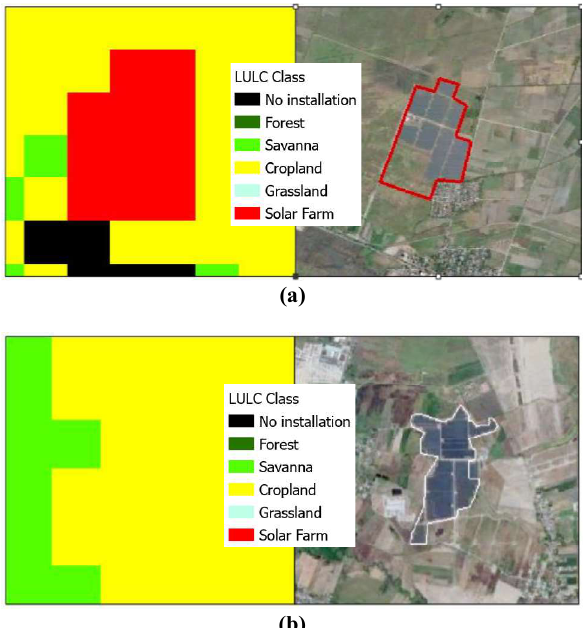
Figure 6 . Predicted of LULC map for year 2027: (a) realistic prediction since solar farm remains as is; (b) unrealistic prediction since solar farm is converted back to